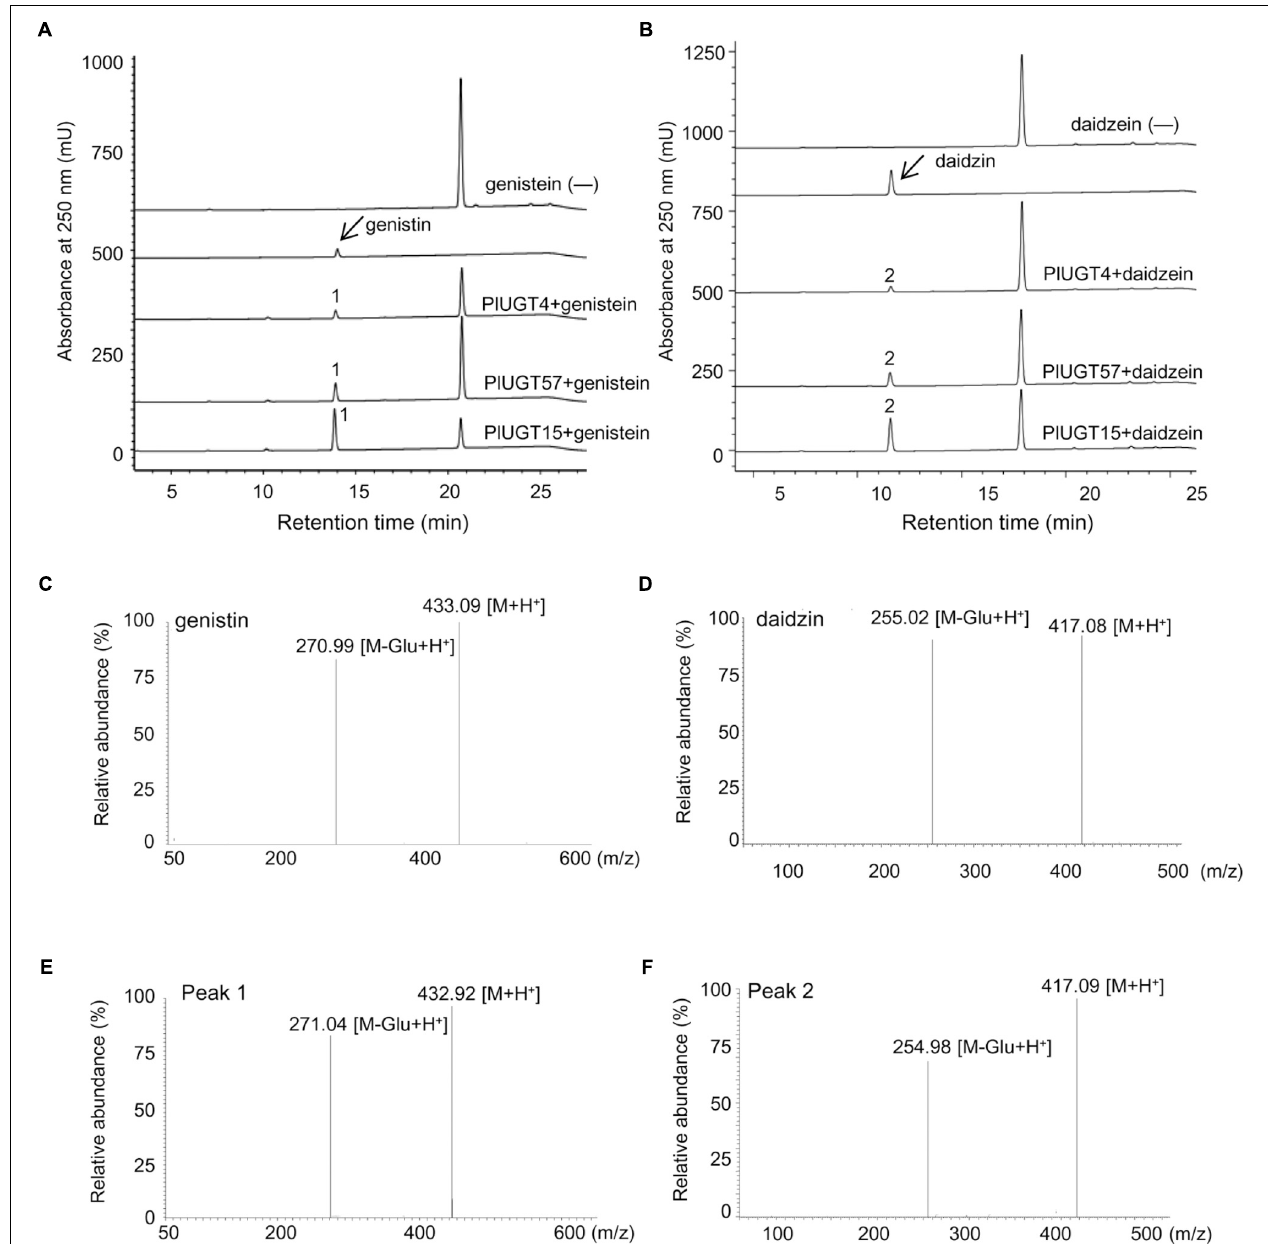
FIGURE 4 | Analysis of the enzymatic reaction products of PlUGTs with isoflavonoid substrates. HPLC chromatograms of reaction products of PlUGT4/PlUGT15/PlUGT57 with genistein (A) and daidzein (B) substrates. Mass fragmentation pattern of genistin (genistein 7- O -glucoside, C ) and daidzin (daidzein 7- O -glucoside, D ) standard. (E,F) are the mass fragmentation pattern of Peak 1 and peak 2, repetitively. (—) Indicate control assays without